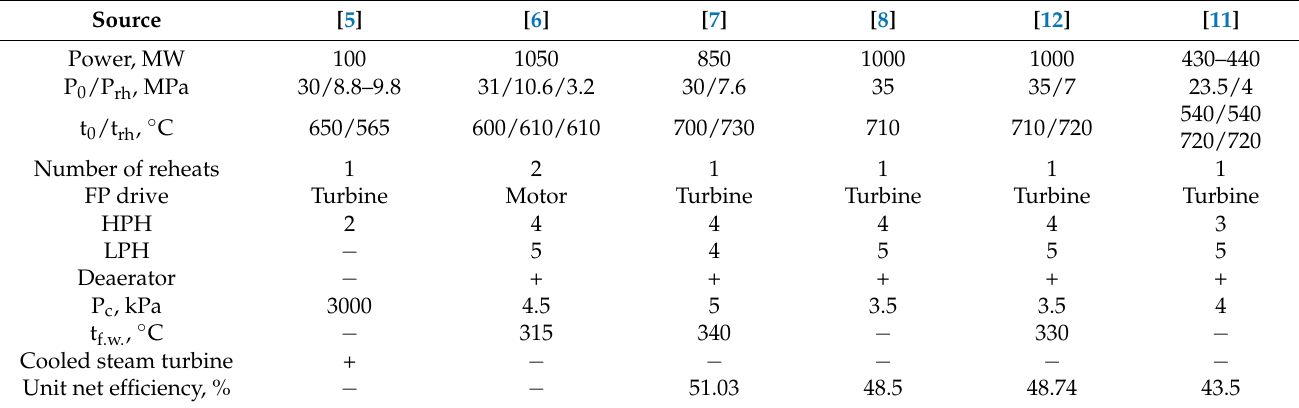
Table 1. Characteristics of SC and USC power